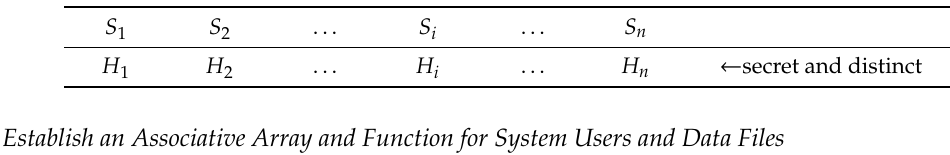
Table 2. Sets of security class and superkey.